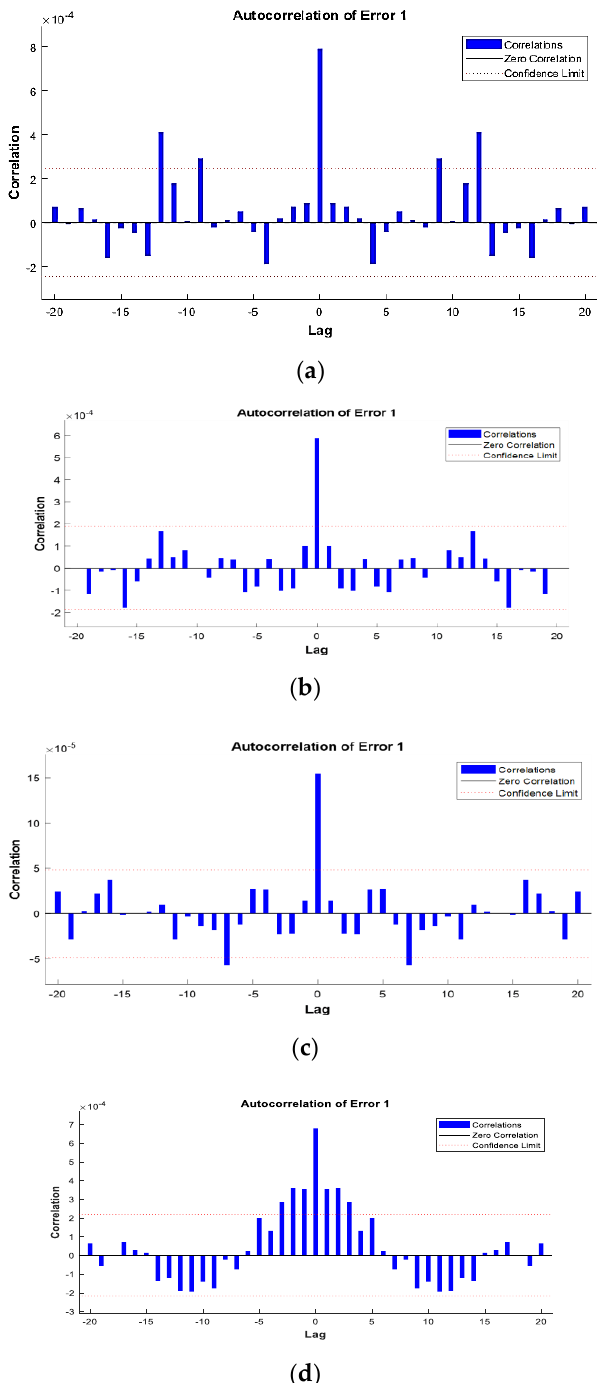
Figure 8. Autocorrelation analysis for the prediction of CO 2 emissions in ( a ) Malaysia, ( b ) Thailand, ( c ) Indonesia, ( d ) the Philippines.